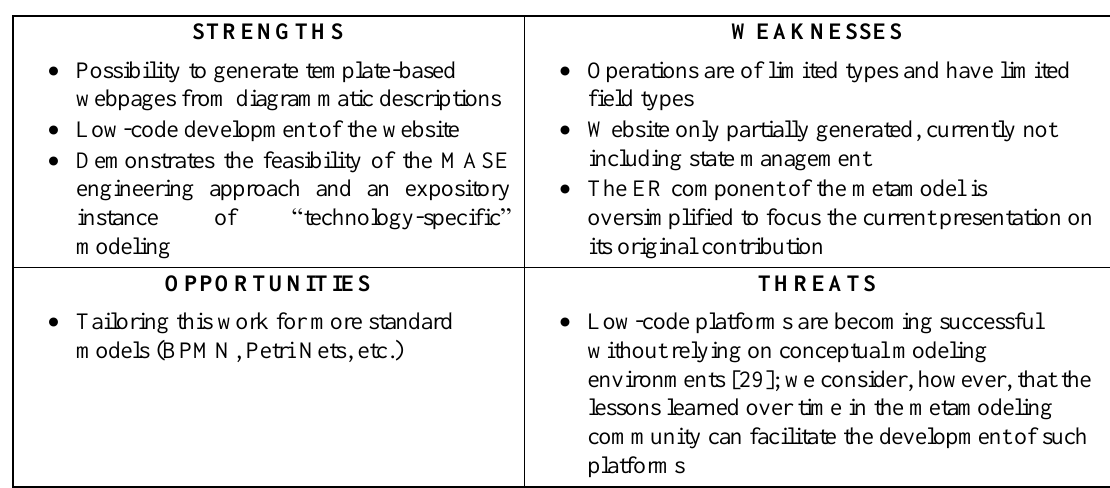
Table 3. SWOT analysis for the proposed